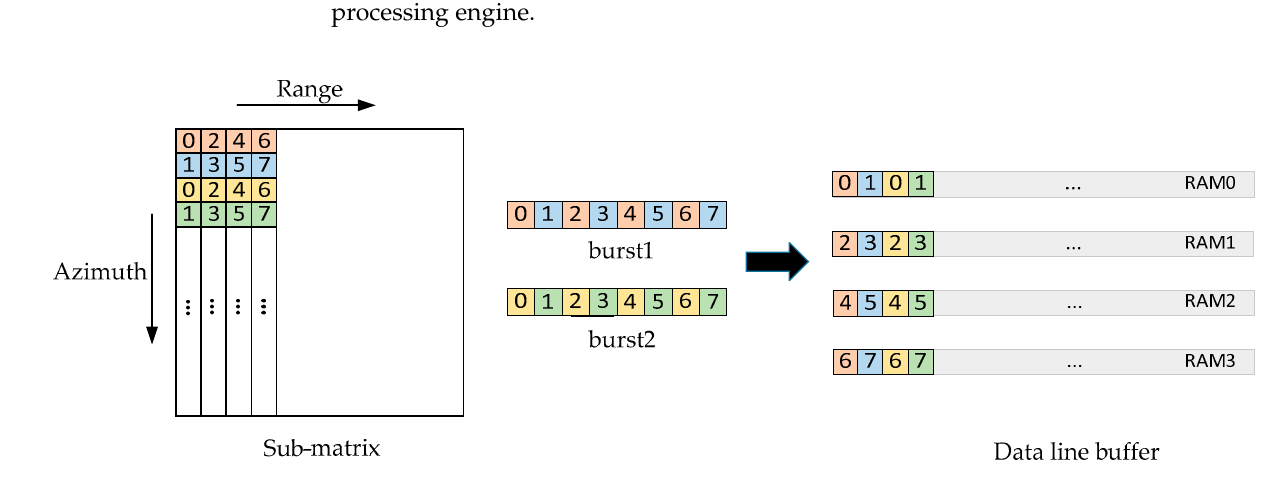
Figure 11. Data access address change method in azimuth direction. ( a ) The four azimuth lines to be accessed in the SAR data matrix; ( b ) the physical addresses of the four azimuth lines to be accessed in DDR3 (each cell represents eight burst transmission data in DDR3; the red dotted line represents the data access sequence in DDR3).